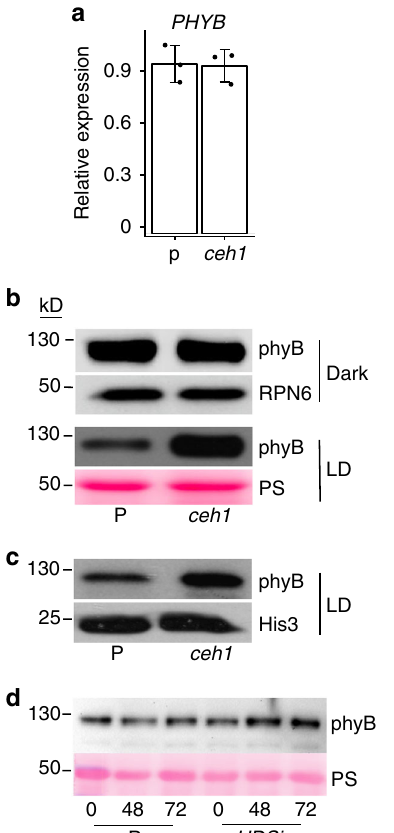
Fig. 2 PhyB protein abundance in MEcPP-accumulating lines. a PHYB expression level is not altered in ceh1 as compared with P. Total RNAs were isolated from 7-day-old seedlings of P and ceh1 grown under long-day (LD; 16 h light/8 h dark) condition and subjected to qRT-PCR analysis. The mRNA levels of PHYB gene was normalized to the levels of At4g26410 (M3E9). Data are mean ± SD of three biological replicates and three technical replicates. Two-tailed Student ’ s t tests con fi rms no signi fi cant differences of PHYB expressions between P and ceh1 . b PhyB protein abundance in dark and LD grown P and ceh1 seedlings. Total proteins extracted from 7-day-old dark and LD grown P and ceh1 seedlings were subjected to immunoblot analyses using phyB antibody. Immunoblot using RPN6 antibody in concert with Ponceau S (PS) staining were used as loading controls for dark and LD grown seedlings, respectively. c Immunoblot analyses of phyB protein levels in nuclear protein extracts from LD grown 7-day-old P and ceh1 seedlings. Blots probed with Histone 3 (His 3) antibody show equal loading of nuclear proteins. d PhyB protein levels in 7-day-old P and DEX-inducible MEcPP-accumulating HDSi seedlings before (0) and hours (48 and 72) post induction. Ponceau S (PS) staining